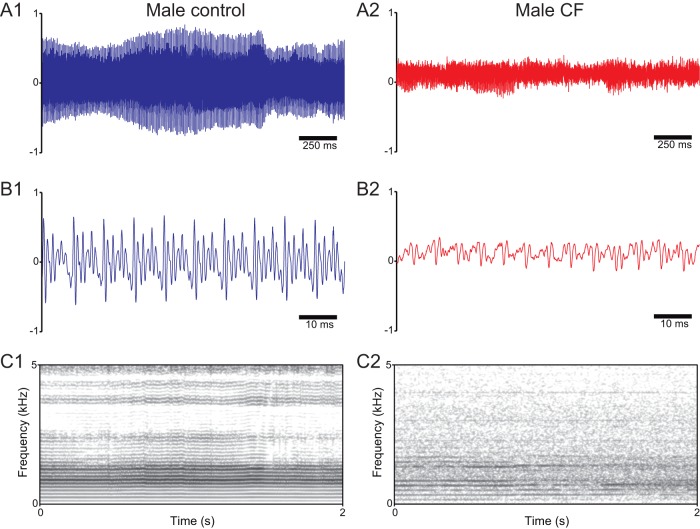
Representative voice recordings and spectrograms of male patients with CF (red) and healthy controls (blue).A: Sound recordings of/a/vowel phonations from a male control subject (A1) and a male patient with CF (A2); note the markedly reduced amplitude range of the signal from the CF patient in relation to the control. B: Amplified views of the recordings presented in A1 and A2; note the irregularity of the voice signal from the CF patient in relation to the control. C: Spectrogram (frequency domain) representations of the recordings presented in A1 and A2; note the higher level of background noise and low formant segregation in the CF patient in relation to the healthy control.